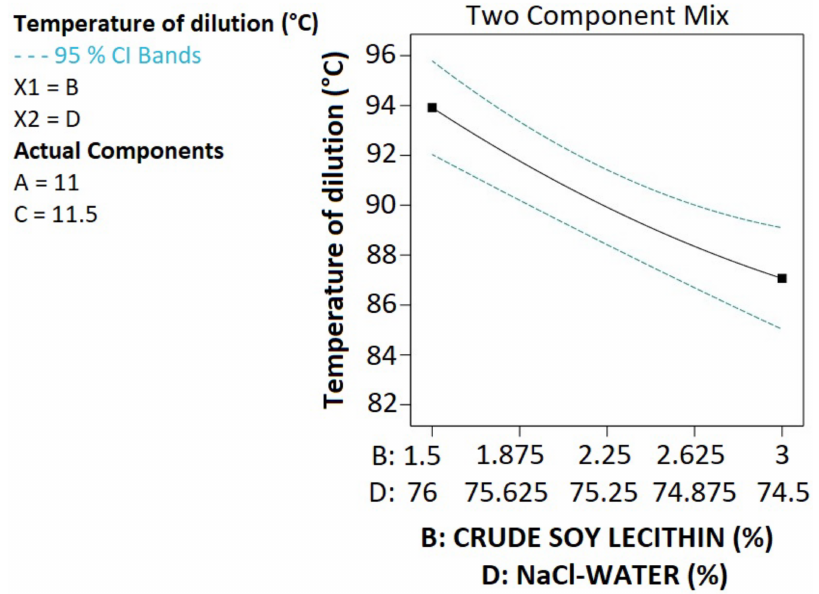
Figure 4. Impact of crude soy lecithin and NaCl-water on temperature of dilution with MCT oil (A) and Tween 80 (C) proportions set, fixed at 11 and 11.5%, respectively.